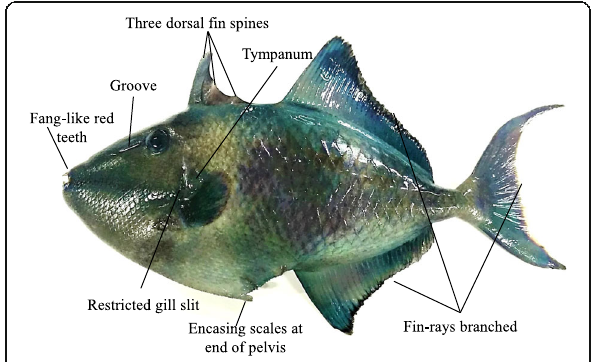
Fig. 1 Red-toothed trigger fish, Odonus niger used for the